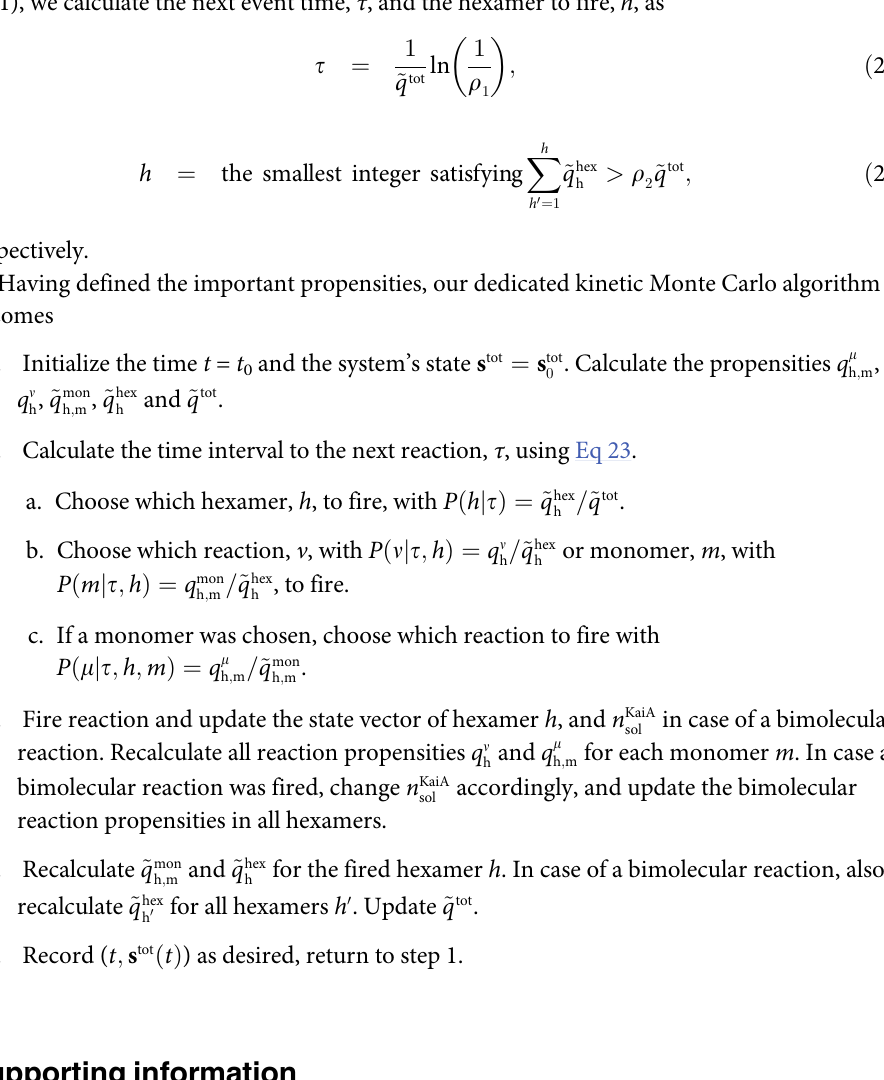
S2 Fig. Alternative model of two KaiA dimers binding to CII domain. Time traces of the phosphorylation level (black line) and the fraction of the CII domains of KaiC hexamers with at least one KaiA dimer bound (purple line), for a modified model where up to two